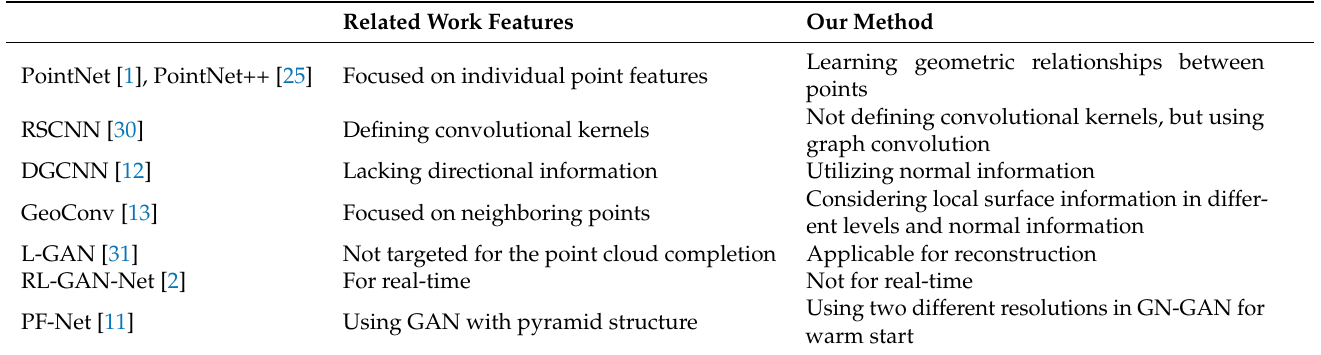
Table 1. Comparison with other